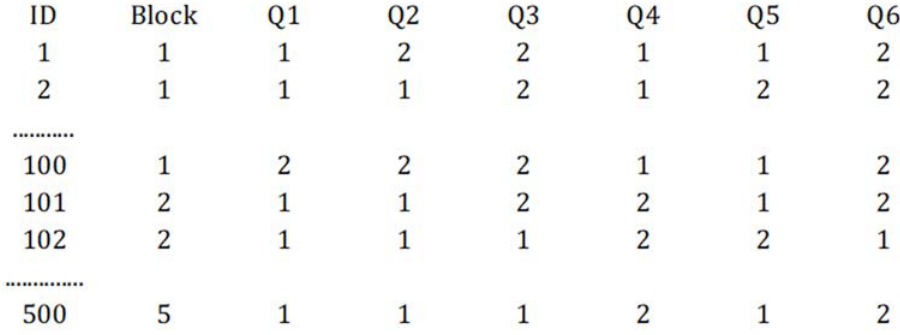
Table 1. Average marginal component